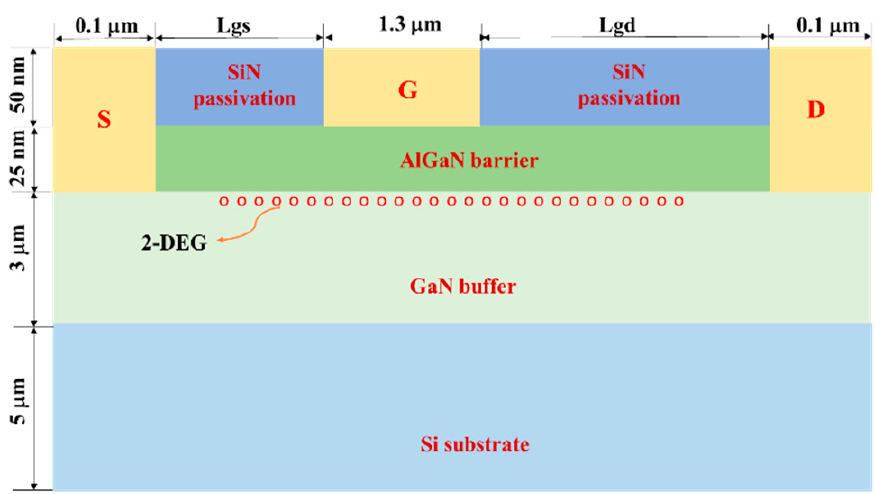
Figure 1. The geometric structure of the GaN HEMT.